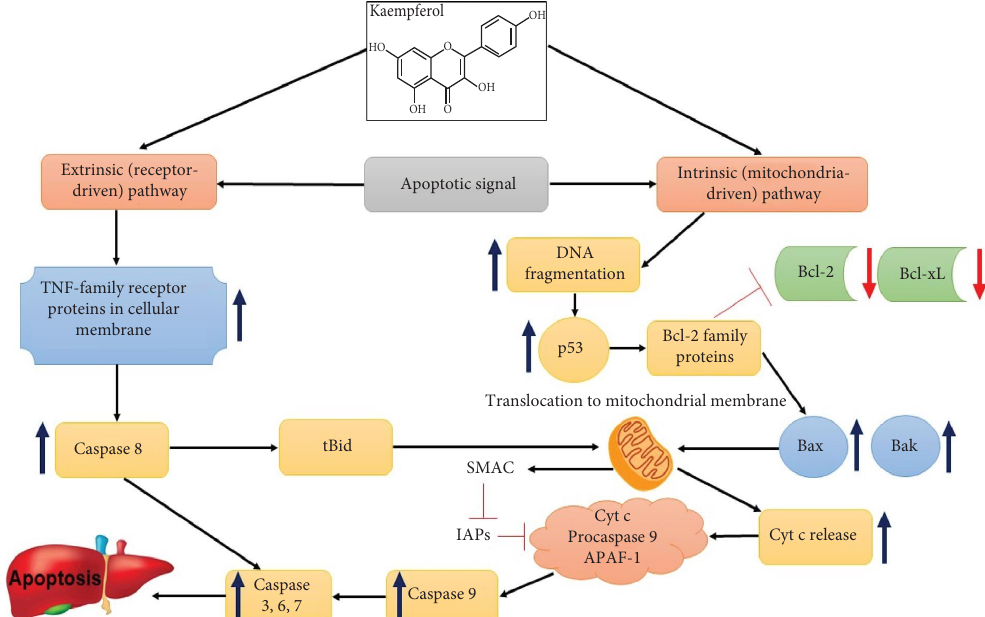
Figure 5: Kaempferol targets in extrinsic and intrinsic apoptosis pathways. Blue arrows show the efect of kaempferol (activation) and red arrows show suppression, inhibition ( ⟞